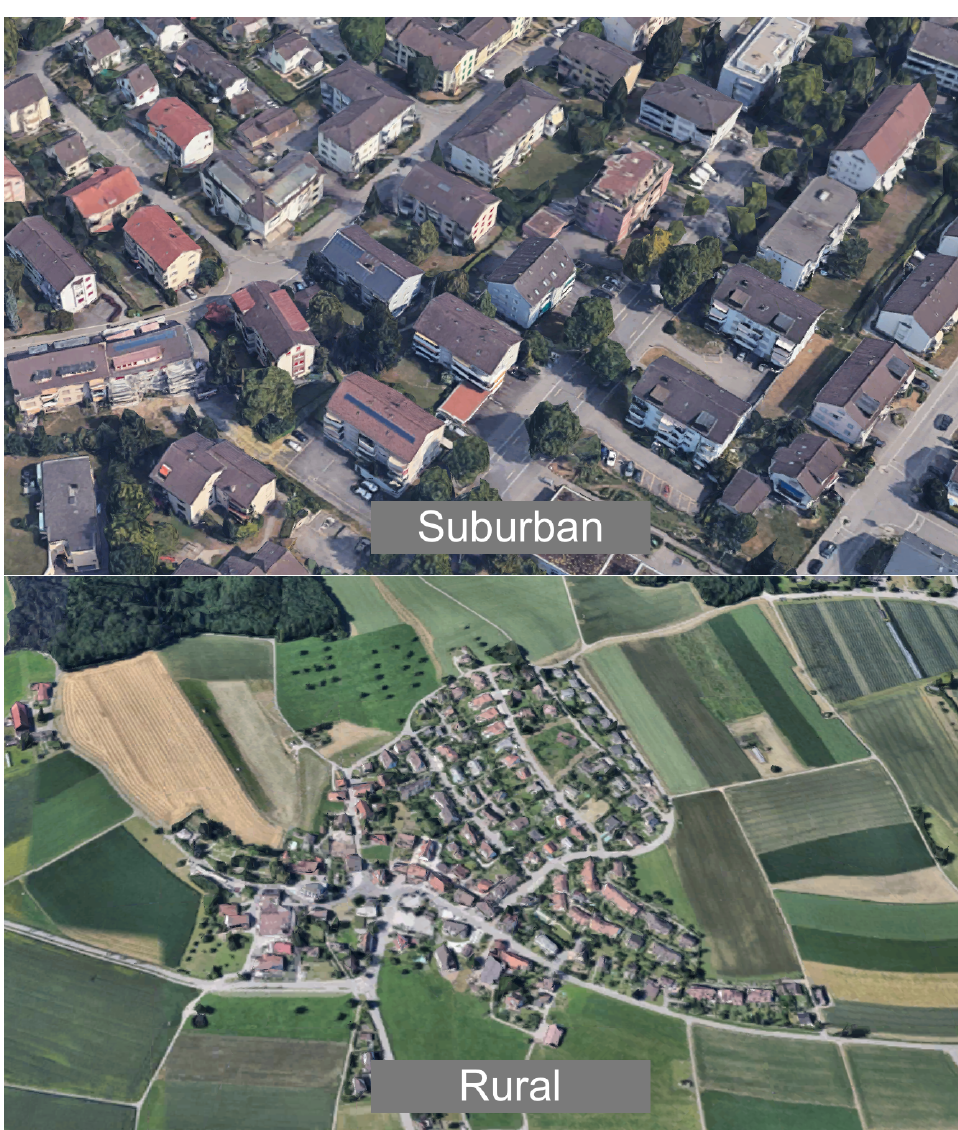
Figure A1. Urban, suburban, and rural areas in the canton of Zurich. (These illustrations show exemplary neighborhoods in urban, suburban, and rural areas of the canton of Zurich. The urban neighborhood is located at Bleicherweg, Zurich. The suburban area can be found at Talackerstrasse, Opfikon, and the rural neighborhood is located at Neuhofstrasse, Lindau. All pictures are taken from Google